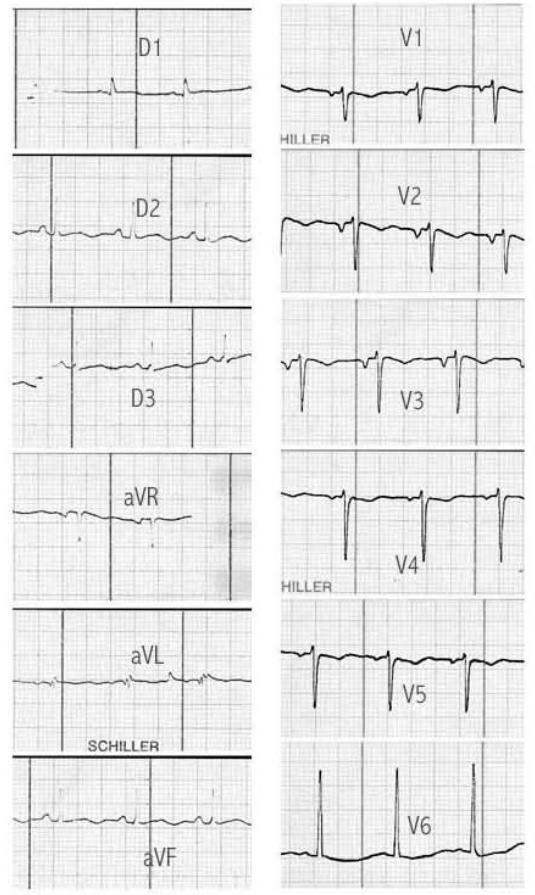
FIGURE 2. Flattened T wave in all leads. Pathological Q waves in leads D1 and aVL and amputate (low voltage) R wave in leads V2-V4. Pathological terminal forces of P wave in lead V1-